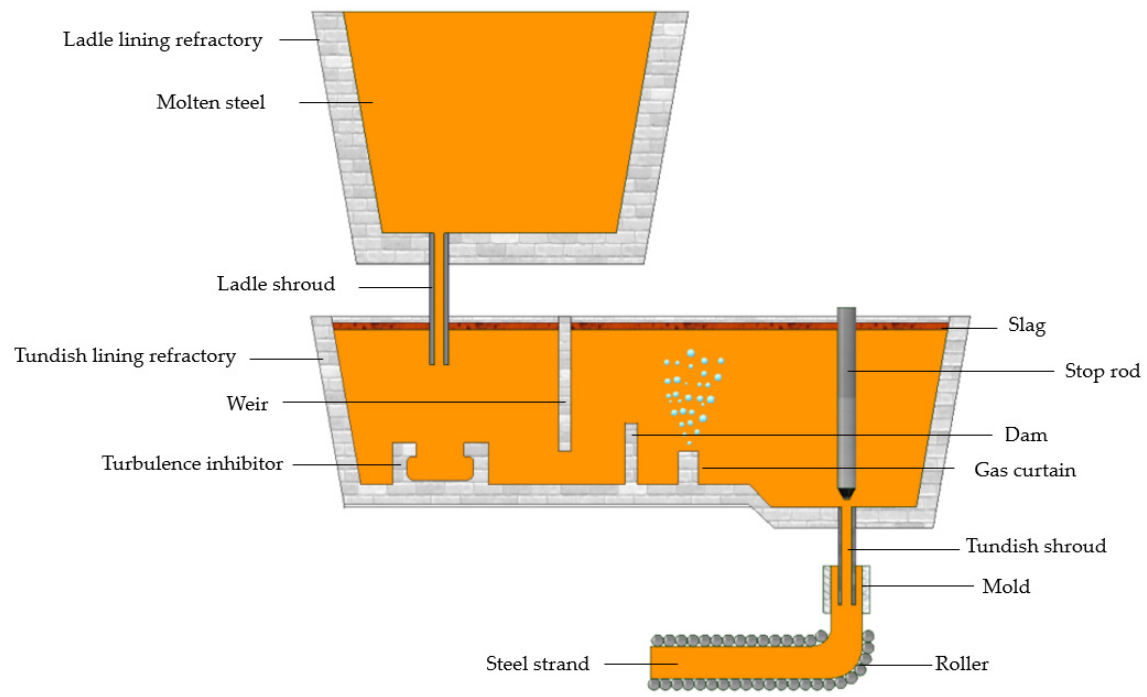
Figure 1. Schematic layout of curved continuous casting machine. (1) Weir: It is mainly used to divide the inlet chamber and the outlet chamber. The appearance of the weir is good for controlling the turbulence in the inlet chamber, benefits the inclusion flotation and decrease the surface wave amplitude in the outlet chamber